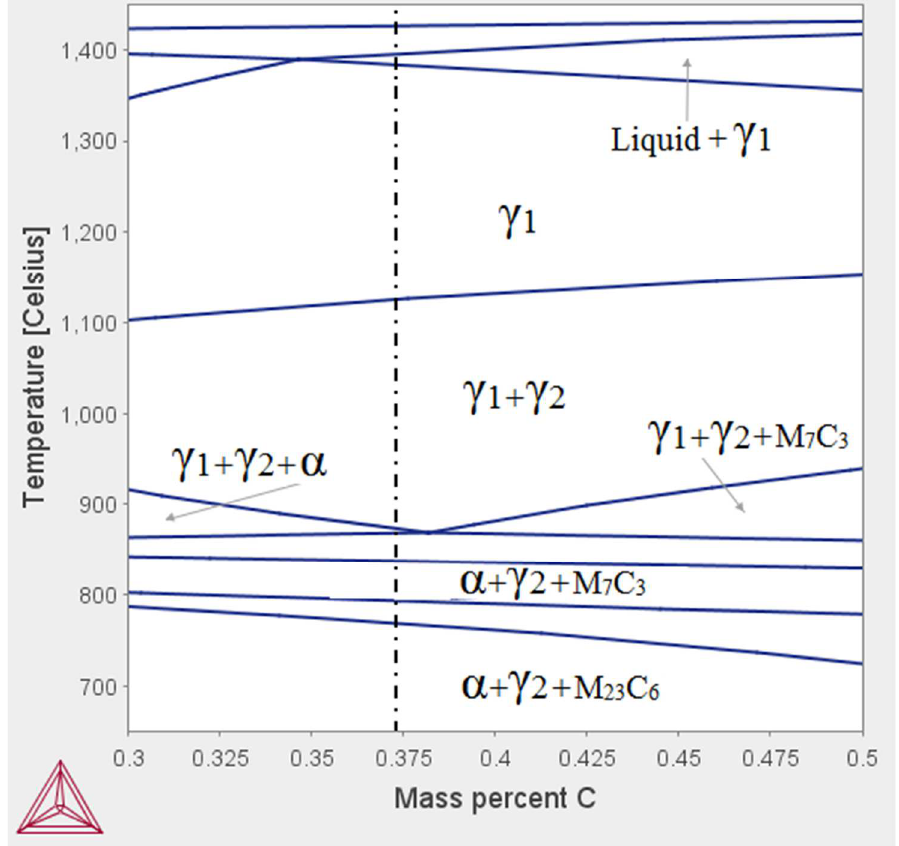
Figure 3. Phase diagram for the AISI H13 alloy (Thermocalc(r)software) according to the carbon content (wt.%). The dashed line indicates the composition of the samples processed in this